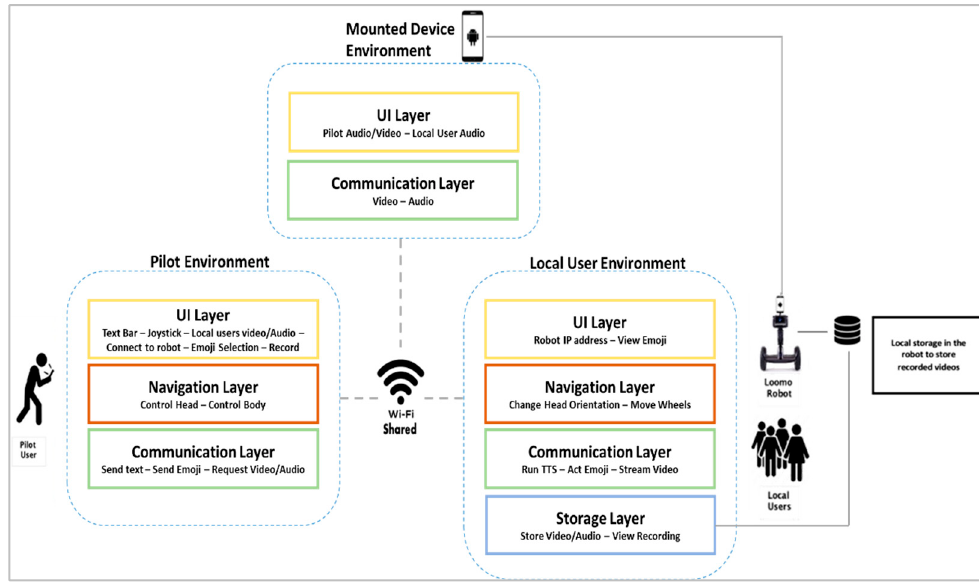
Figure 5. Architecture of the proposed MRP system.